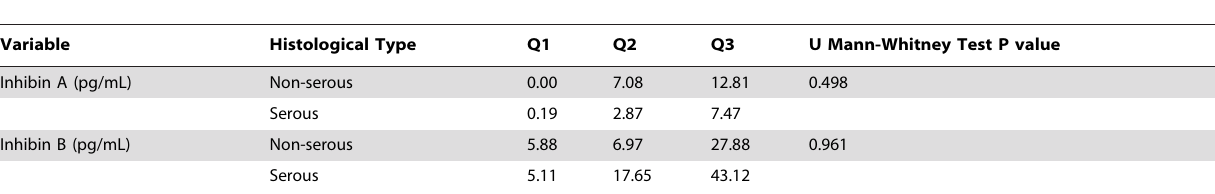
Table 4. Inhibin A and inhibin B concentrations in relation to the histological type of cancer.